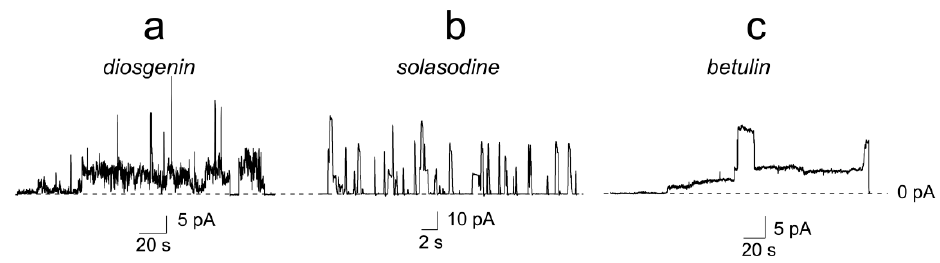
Figure 1. Current fluctuations corresponding to the openings and closures of single ion-permeable pores induced by 150 µM of diosgenin ( a ), solasodine ( b ), and betulin ( c ). Lipid bilayers were formed from DPhPC and bathed in 0.1 M KCl (pH 7.4). V = 100 mV.